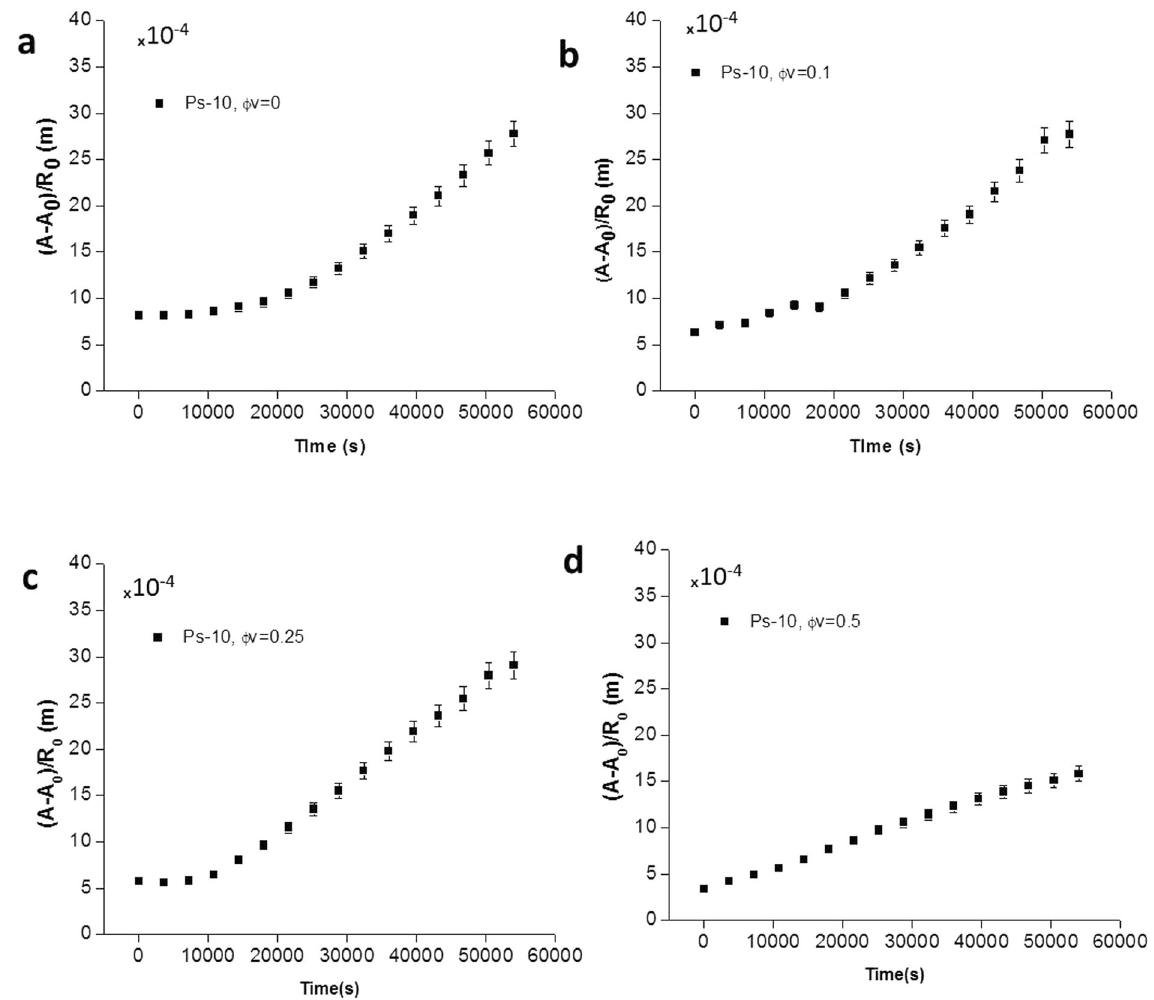
Fig. 8 Dynamics of spreading of hybrid aggregates. Time evolution of the area of the cell monolayer of a hybrid spreading aggregate (formed with Ps-10 MPs) normalized by the initial aggregate radius R 0 . a Ф V = 0 with R 0 ranging from 200 to 285 μ m; b Ф V = 0.1 with R 0 ranging from 150 to 190 μ m; c Ф V = 0.25 with R 0 ranging from 125 to 160 μ m, and d Ф V = 0.5 with R 0 ranging from 50 to 110 μ m. Error bars represent the standard deviation of n = 10